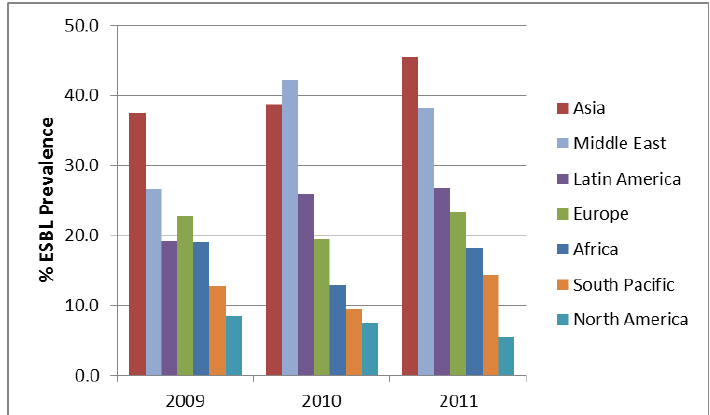
Figure 3. Prevalence of ESBLs in E. coli , K. pneumonia , K. oxytoca and P. mirabilis from urinary-tract infections by region from SMART 2009 to